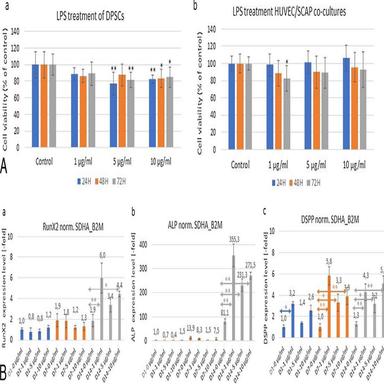
A: Evaluation of cell viability of 2D DPSC (a) and HUVEC/SCAP (b) cultures at 24, 48 or 72h of treatment with LPS (1, 5 or 10 g/ml) by the MTT assay. The results are presented as % percentage of the control cultures (not exposed to LPS treatment). Asterisks indicate statistically significant differences compared to the control cultures at each time-point (\p < 0.05, \\p < 0.01). 3B: Real-time PCR analysis of the expression of odontogenesis-related genes, including a. RUNX2, b. ALP and c. DSPP at D1, D7 and